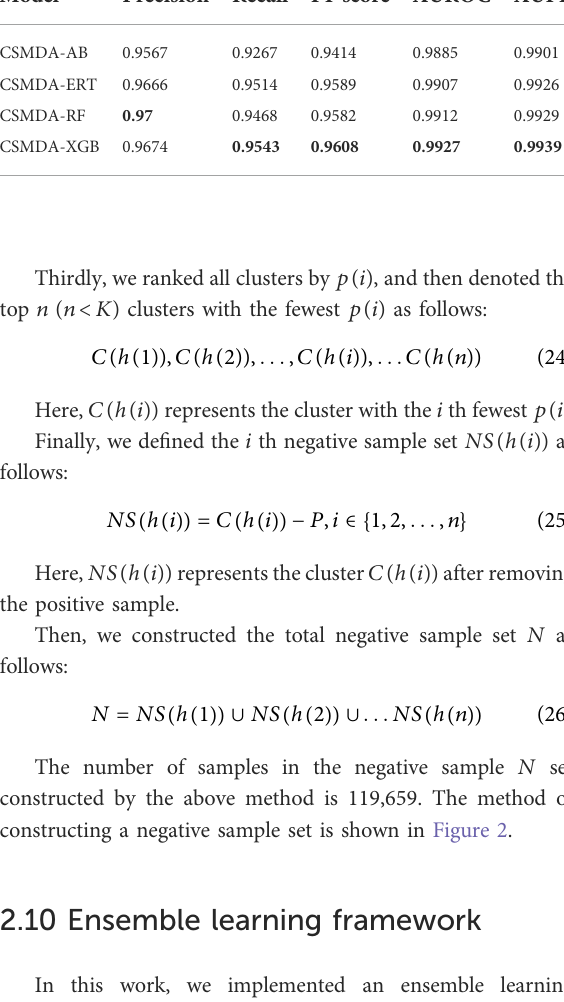
TABLE 1 Performance comparison of the CSMDA using different base classi fi ers.